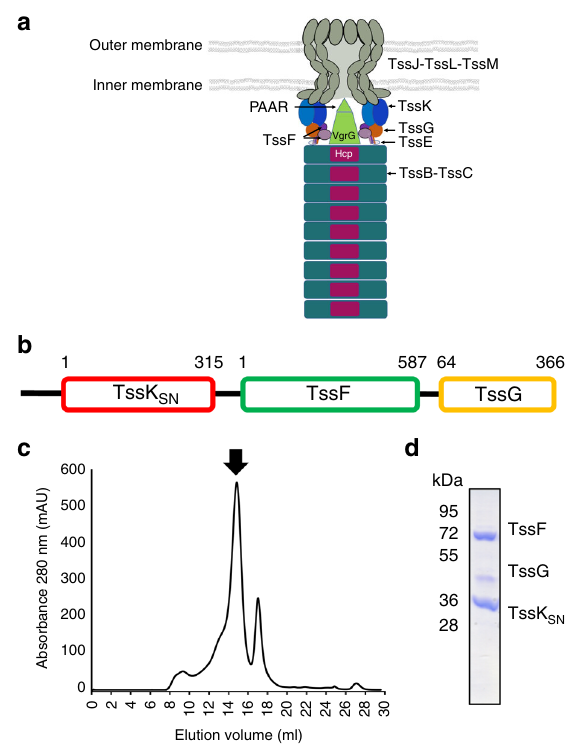
Fig. 1 Schematic of the T6SS apparatus, construct design, expression, and puri fi cation of the EAEC TssK SN -TssF – TssG complex. a Schematic of the T6SS apparatus. TssE is rendered semi-transparently owing to uncertainty in its position. TssA is not shown. b Schematic representation of the construct used for recombinant expression. c Size-exclusion chromatogram after af fi nity puri fi cation. d SDS-PAGE of the fraction indicated with an arrow in c . Molecular weights from the ladder are indicated on the